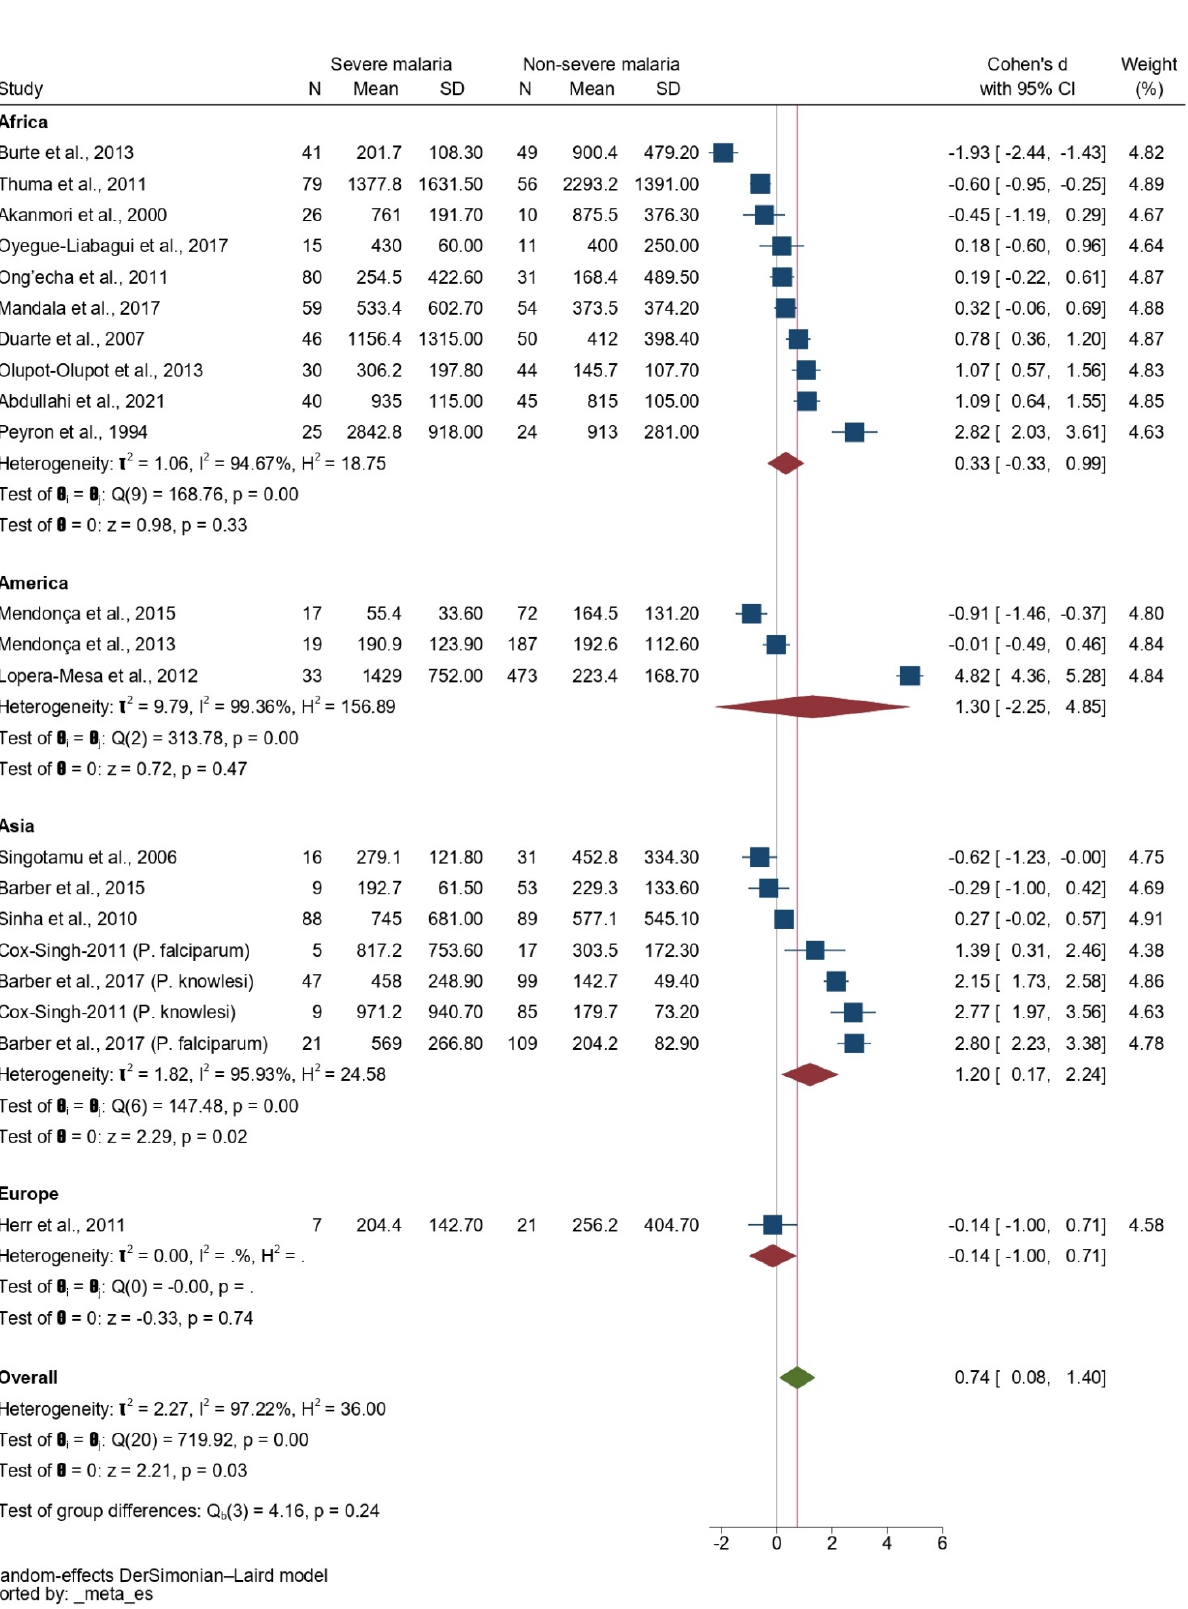
Figure 4. Forrest plot showing the SMDs of IL-10 levels between patients with severe malaria and patients with non-severe malaria stratified by continents. Abbreviations: CI, confidence interval; SD, standard deviation. Symbols: blue square, point estimate (SMD of IL-10); green diamond, pooled effect estimate (pooled SMD of IL-10); red diamond, pooled effect estimate in each